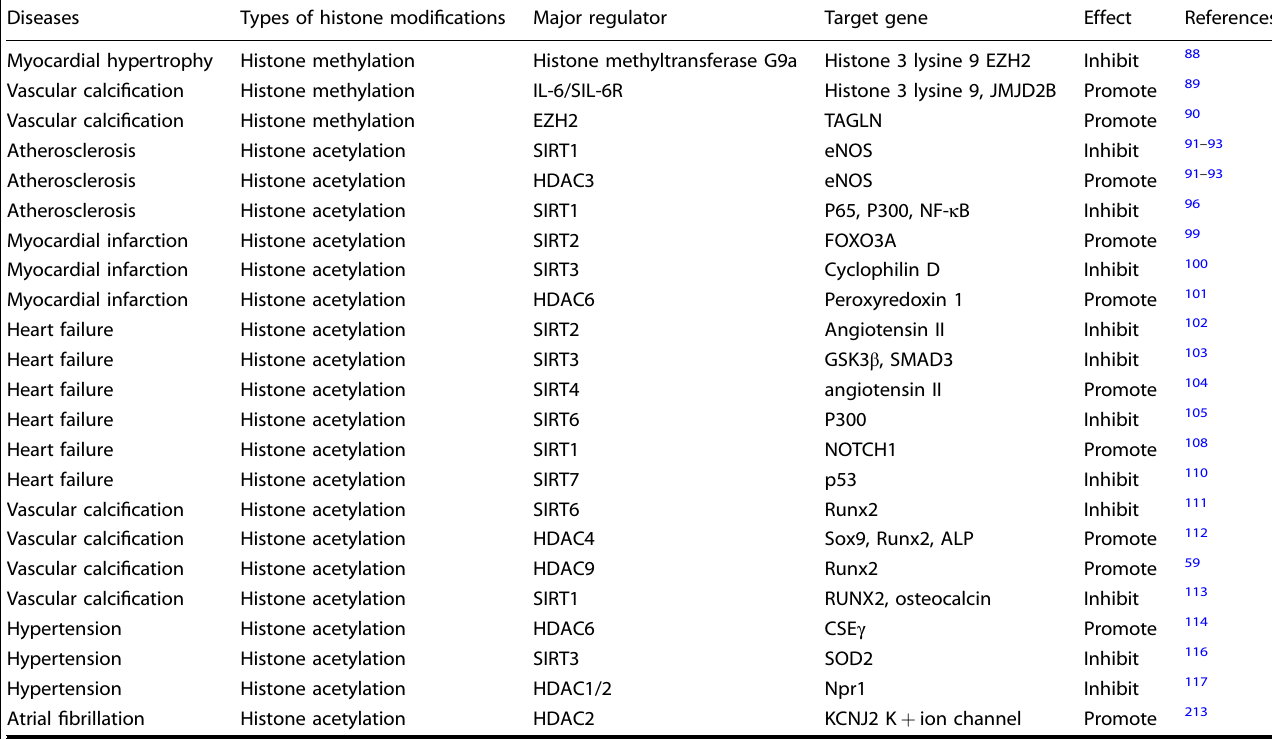
Table 3. Regulation of histone modi fi cation in cardiovascular disease